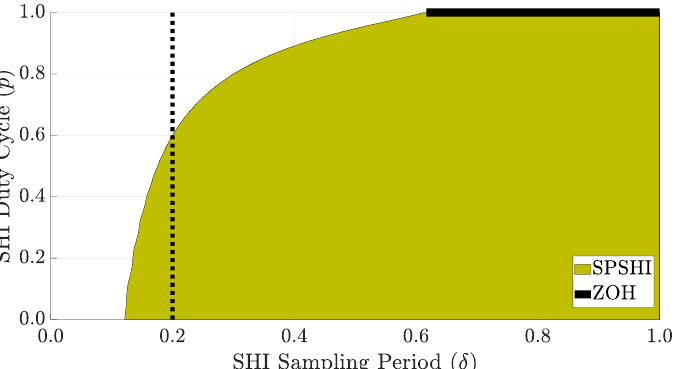
Figure 4. The feasible sampling period (in s ) of ZOH that results in an MP DT system and the p - δ feasible regions of